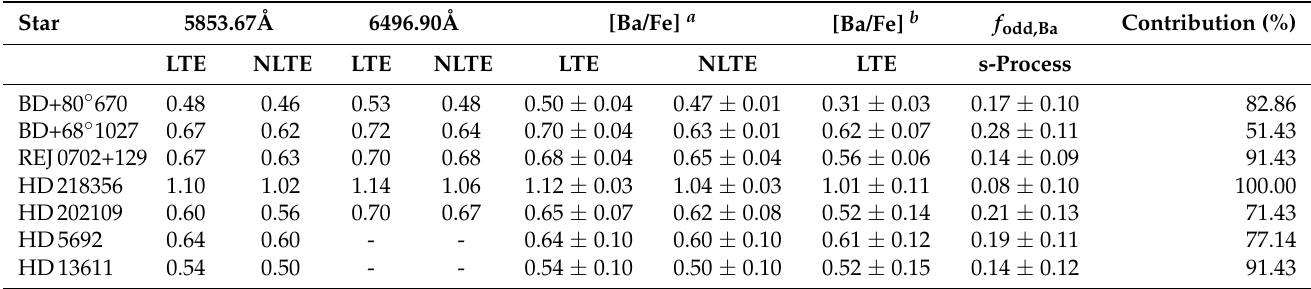
Table 3. The Ba abundances of our seven stars with NLTE and LTE